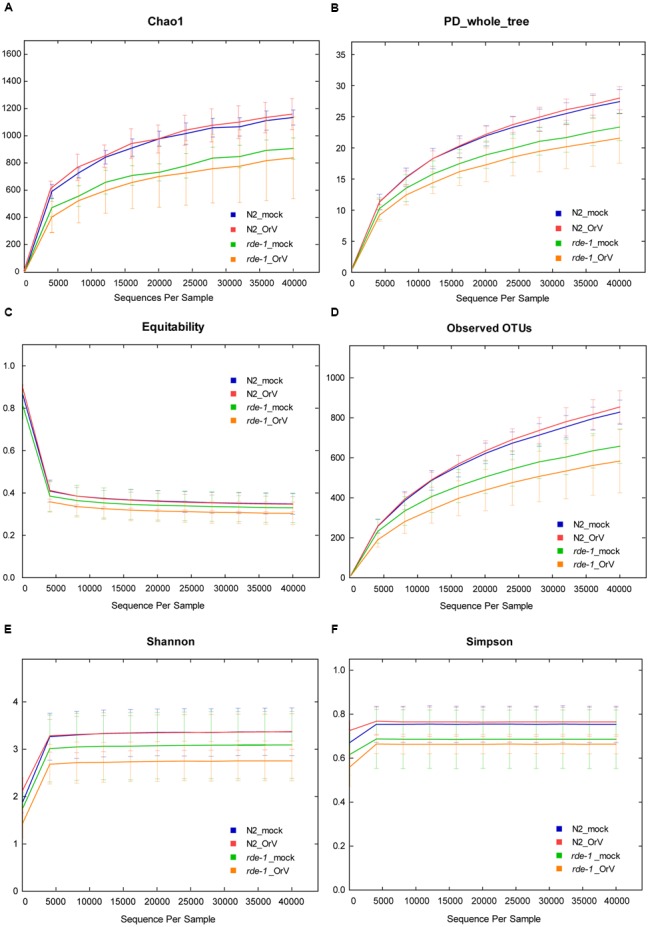
Calculation of alpha diversity values for comparison of the total microbial diversity of uninfected and Orsay virus-infected groups of N2 and rde-1 (ne219) mutant. (A) The estimated OTU numbers (Chao1) of N2 were greater than that of rde-1 (ne219) mutants, which especially decreased in Orsay virus-infected rde-1 (ne219) mutants. (B) Phylogenetic diversity (PD) measures of community diversity. (C) Equitability index of the microbiota data for N2 and rde-1 (ne219) mutants. (D) The numbers of observed OTUs decreased in both uninfected and Orsay virus-infected rde-1 (ne219) mutants. (E) Microbial community diversity analysis (Shannon index) showed that the N2 community exhibited greater diversity. (F) Simpson index measures of community diversity.